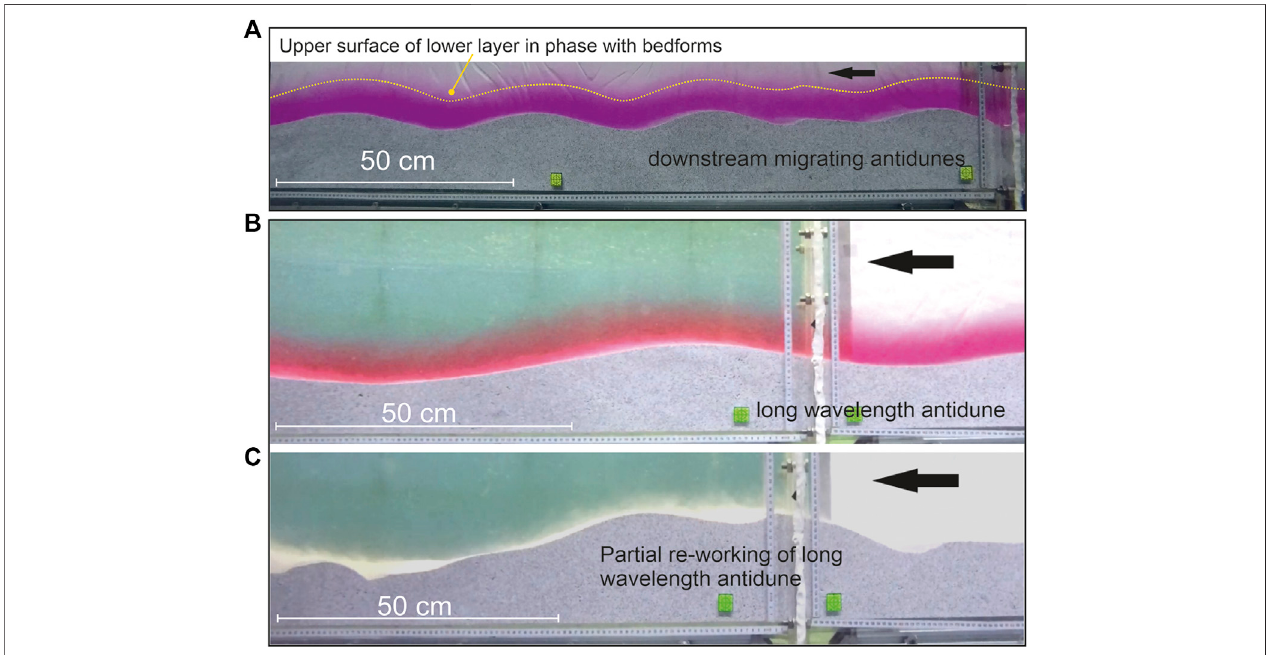
FIGURE 11 | (A) Experiment 1: Example of the in phase, downstream migrating antidunes formed under steady fl ow conditions. The yellow dotted line de fi nes the upper surface ofthe lowerdenser layer ofthe current. (B) Experiment 2: Exampleofa longwavelength antidune. Itis inphase withthe upper surface ofthe lower denser layer of the current (dyed pink). (C) Partial re-working of the long wavelength antidune. Flow is from right to left in all photos (arrows).